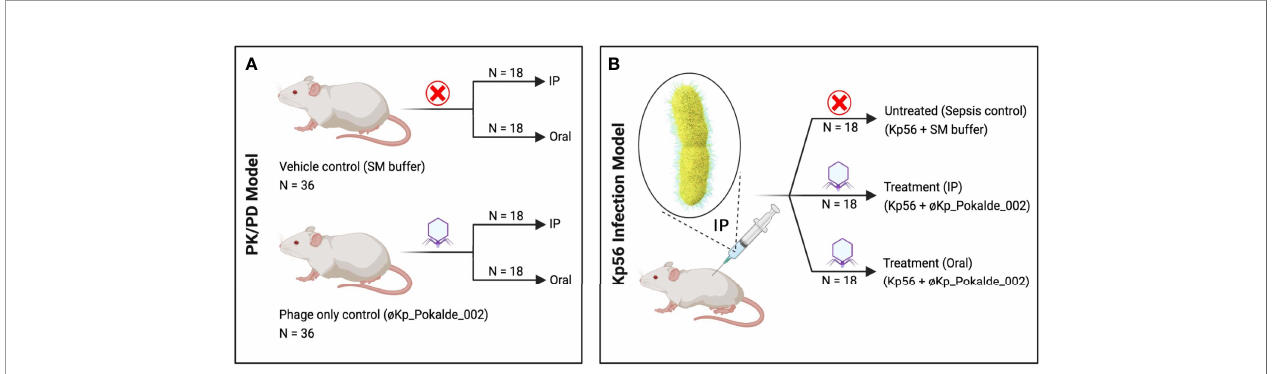
FIGURE 1 | Schematic representation of the experimental design. (A) In PK/PD model, SM buffer (vehicle control) and same dose of puri fi ed øKp_Pokalde_002 (phage only control) was administered via both IP and oral route. (B) In Kp56 infection model, bacteria ( K. pneumoniae ) were administered via IP route only, while treatment (øKp_Pokalde_002) was administered via both IP and oral route. Figure created in BioRender.com. PK, pharmacokinetics; PD, pharmacodynamics; SM, Sodium Magnesium; IP,